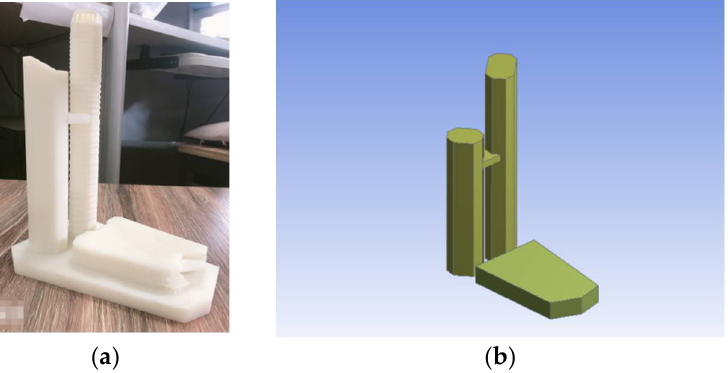
Figure 12. Numerical simulation and wind tunnel experimental model. ( a ) Wind tunnel experiment model; ( b ) Numerical simulation model.